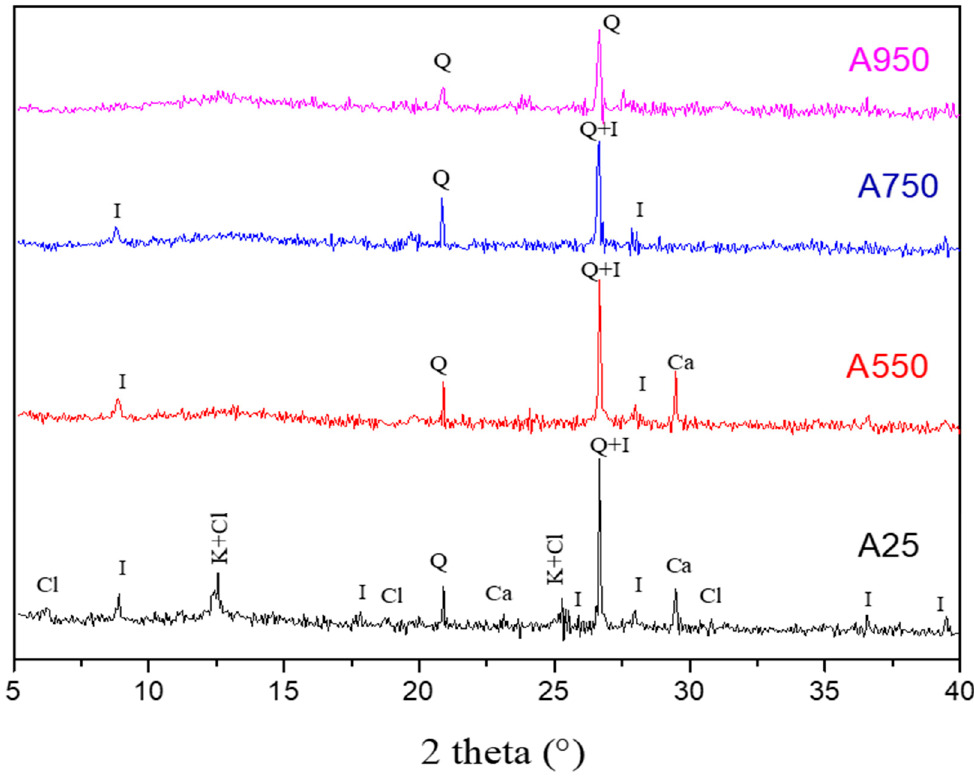
Figure 6. Diffractograms of A25, A550, A750, and A950 samples with K—Kaolinite (00-003-0058), Q—Quartz (01-082-0511), I—Illite (00-026-0911), Ca—Calcite (00-002-0629), Cl—Clinochlore (00-029-0701) .